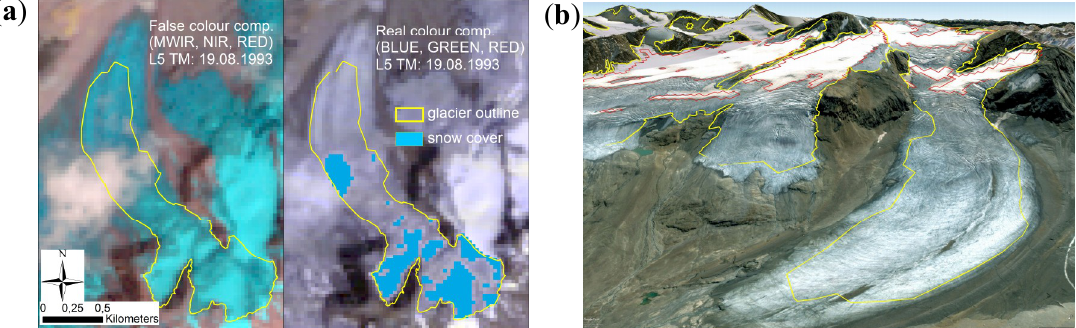
Figure 12. ( a ) The eastern part of HJF with a cloud hiding a part of its tongue. The classification on the right shows that the cloud was mapped as snow, which resulted in wrong values from the SLA detection method. ( b ) Google Earth view (image from 12 August 2003) from HJF. The red outlines show the snow classification from 30 July 2003 and yellow lines mark the glacier mask from 2011.